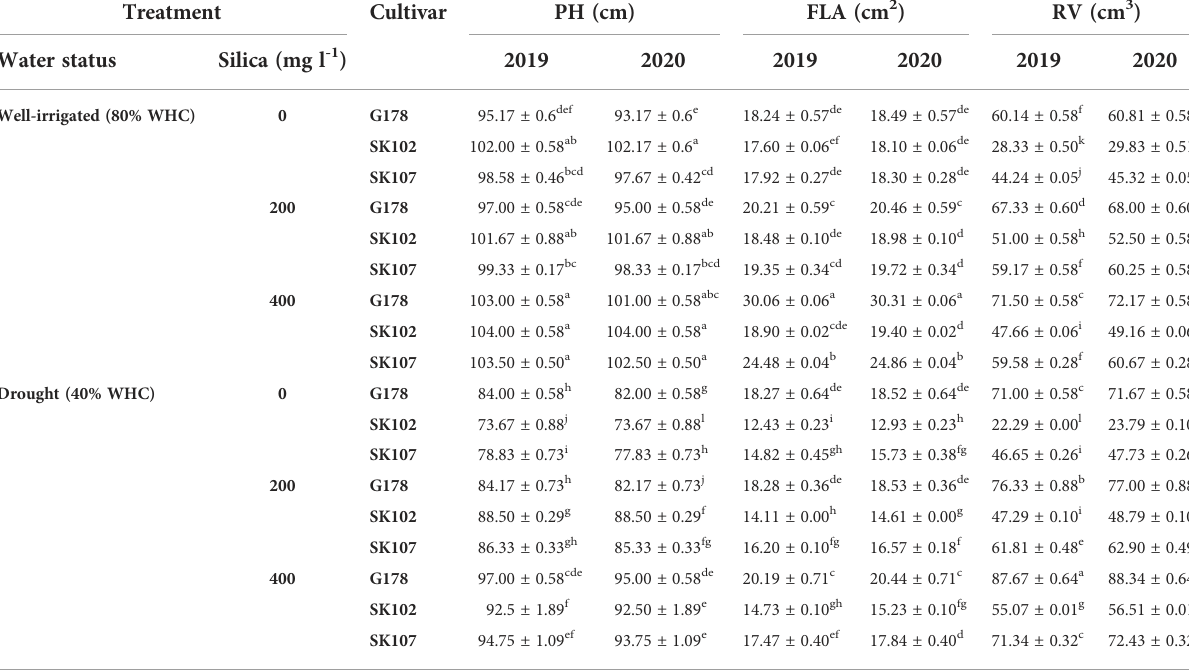
TABLE 1 Effects of foliar application of silica on some morphological parameters at vegetative stage in response to drought stress during the growing seasons of 2019 and 2020.